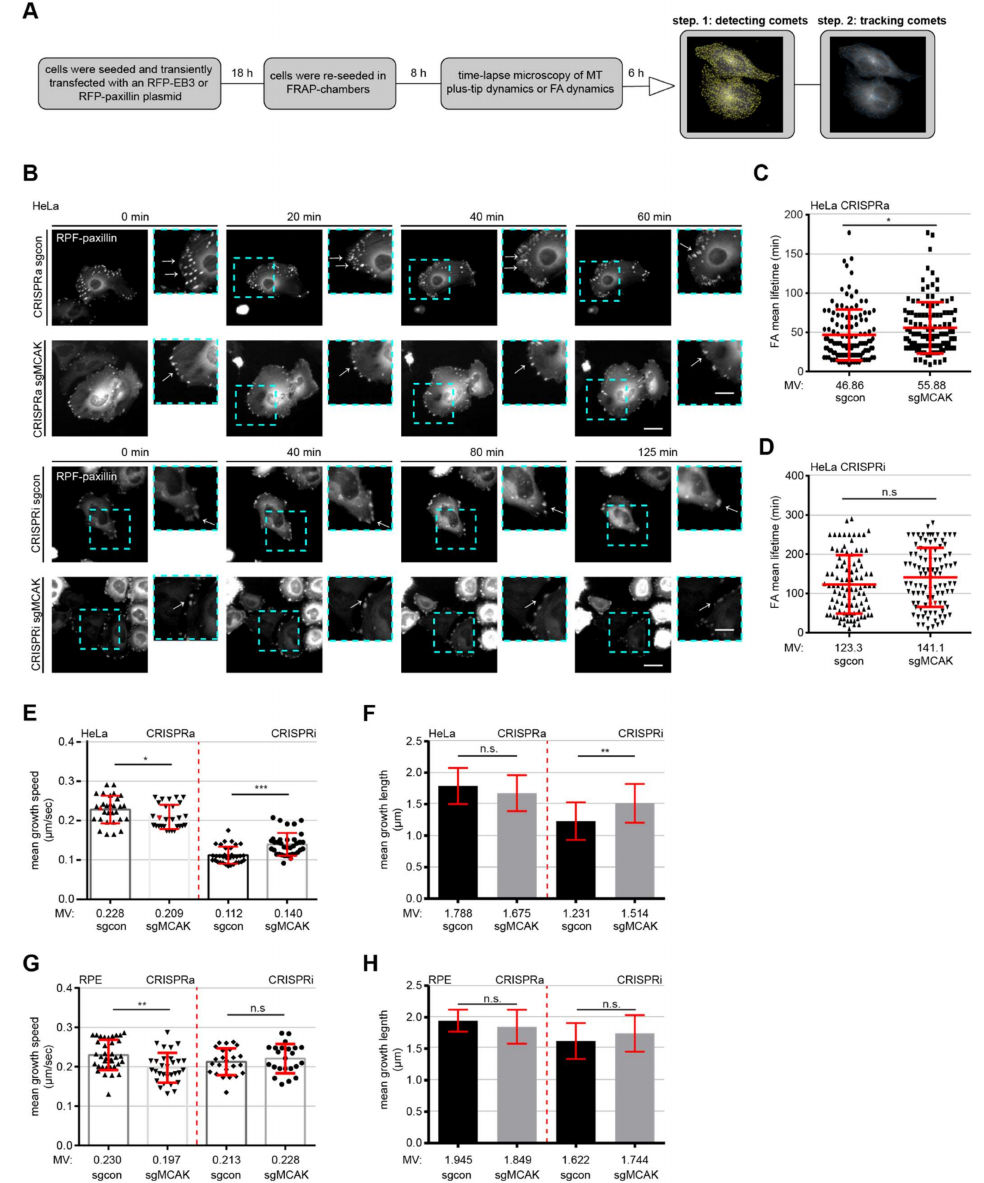
Figure 7. MCAK modulates FA stability and MT dynamics . ( A ) Schedule of the FA stability and EB3 comet tracing assay. Time-lapse microscopy was performed with HeLa CRISPRi/a cells transfected with RFP-paxillin ( B–D ) or RFP-EB3 ( E – H ). The analysis of the FA stability was conducted with ImageJ and the comet detection/tracking was executed with U-track Master, a MatLab plugin. ( B ) Representatives of the FA stability are shown in HeLa CRISPRi/a cells at indicated time points. Scale: 25 µ m, inset scale: 12.5 µ m. The mean FA lifetime (180 FAs per condition) is quantified in HeLa CRISPRa ( C ) and CRISPRi ( D ) cells. The results are based on three independent experiments and presented as scatter plots showing mean ± SEM. ( E , G ) Plus-end mean growth velocity of RFP-EB3 comets was evaluated in HeLa ( E ) and RPE ( G ) CRISPRi/a cells. The results are based on three independent experiments and presented as scatter plots showing mean ± SEM (30 cells per conditions, >45.000 comets tracked). ( F , H ) Mean RFP-EB3 comet track growth length was evaluated in HeLa ( F ) and RPE ( H ) CRISPRi/a cells. The results are based on three independent experiments and presented as bar graphs showing mean ± SEM (30 cells per conditions). Unpaired Mann–Whitney U test was used. * p < 0.05, ** p < 0.01, and *** p < 0.001. Abbreviation: n.s.: not